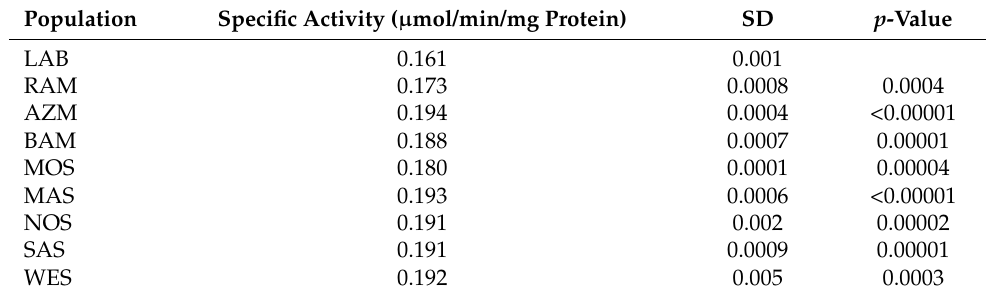
Table 4. Activity of AChE in laboratory strain and field populations of